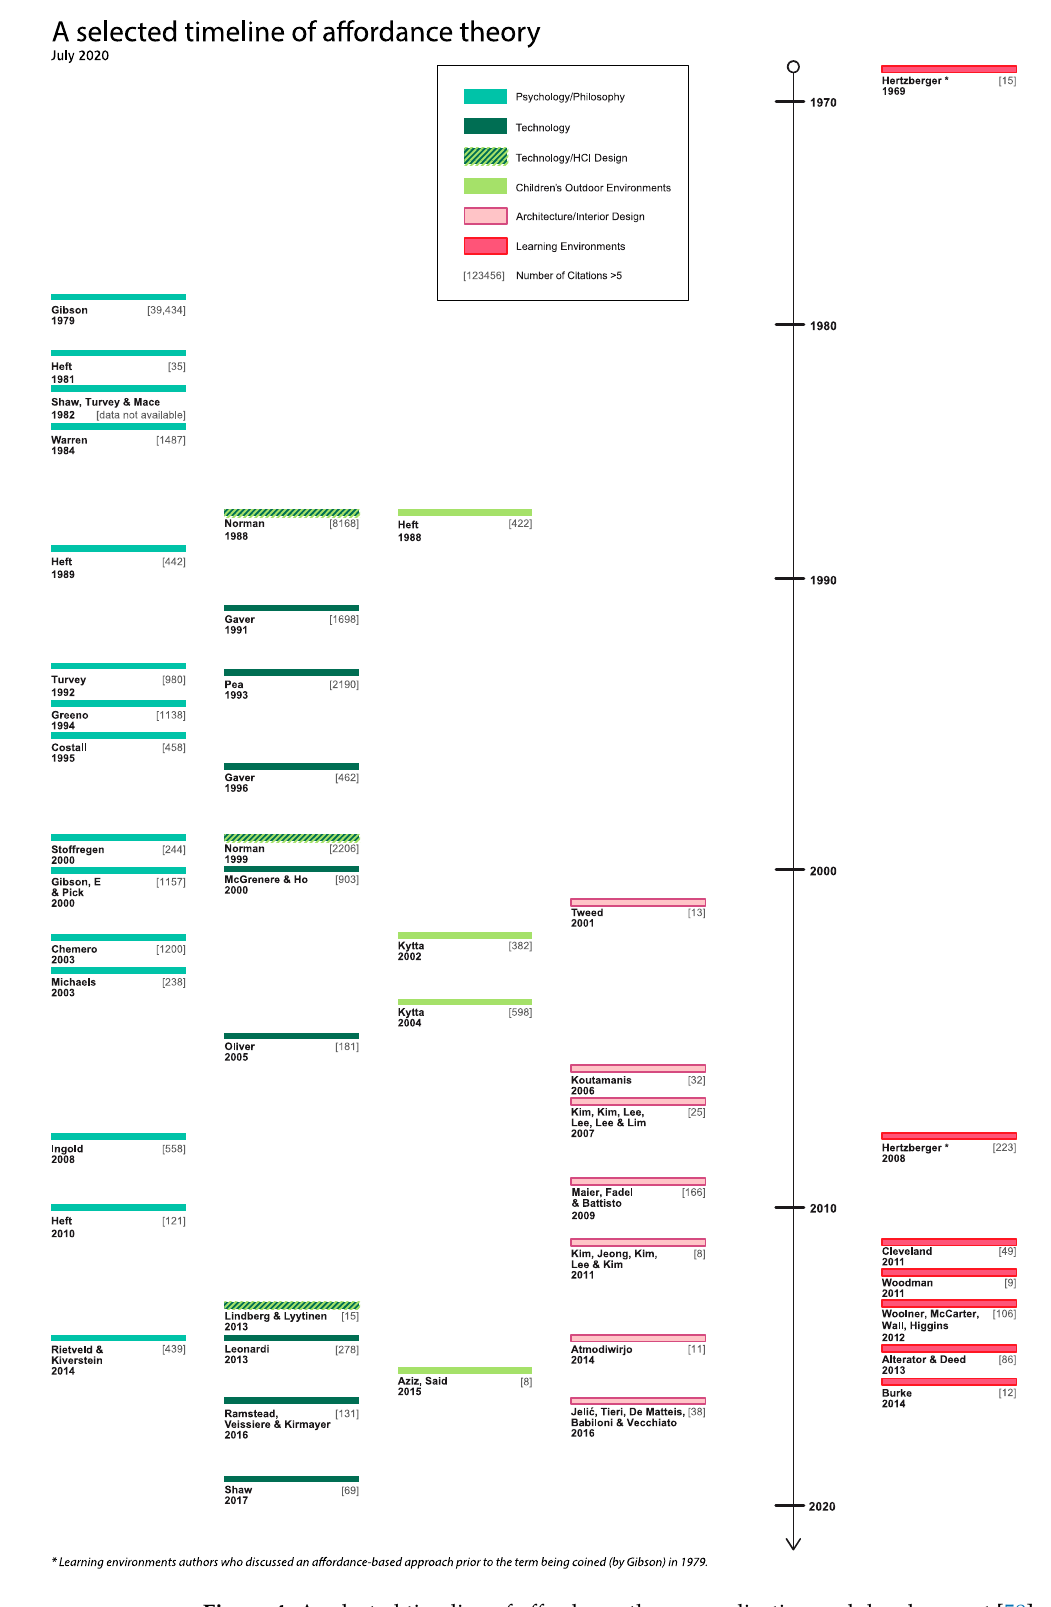
Figure 4. A selected timeline of affordance theory application and development [58].